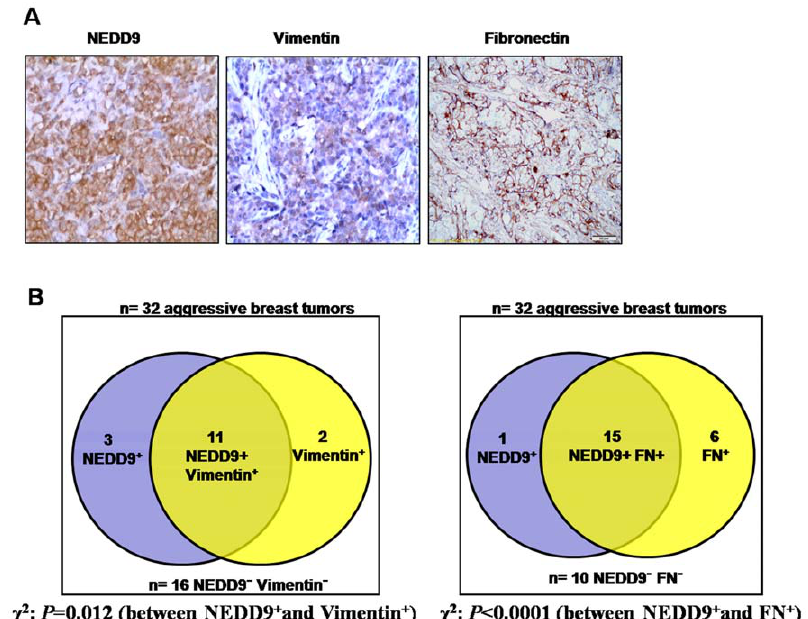
Figure 5. NEDD9 promoted the EMT in aggressive breast tumor. A, Representative immunohistochemical images of an aggressive breast tumor sample stained for NEDD9 and Vimentin. B, Venn diagram showing the association between NEDD9 and Vimentin in aggressive breast tumors.